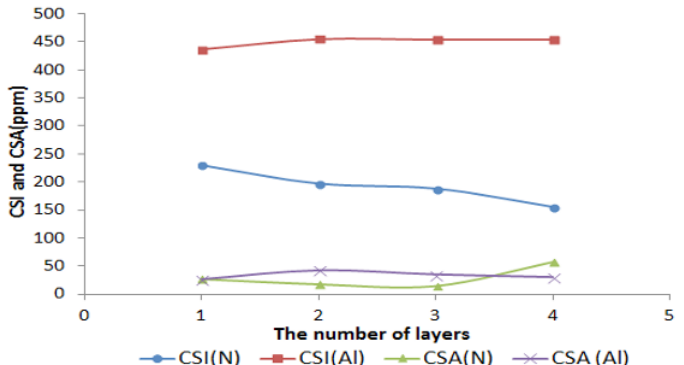
Figure 6. The NMR parameters for pristine (10, 0) zigzag AlNNT.